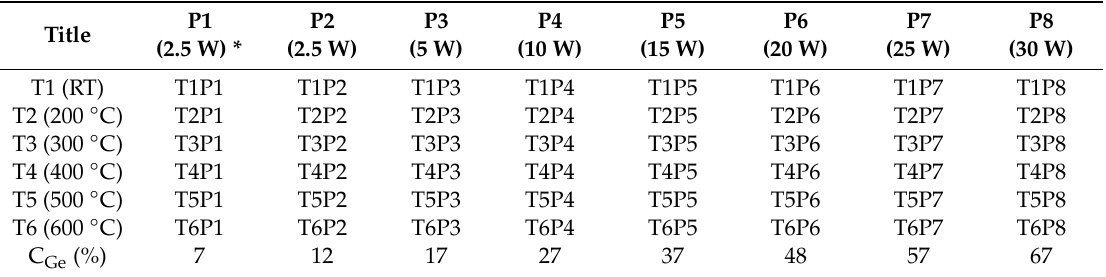
Table 1. Deposition parameters of the films and Ge concentrations. Sputtering power of Al 2 O 3 was 140 W for all films except those indicated by * for which it was 200 W. The last row shows the measured concentrations of Ge (at. %) obtained for each sputtering